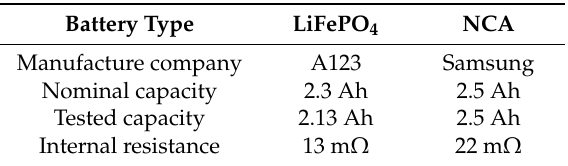
Table 2. Specifications of the two types of Battery